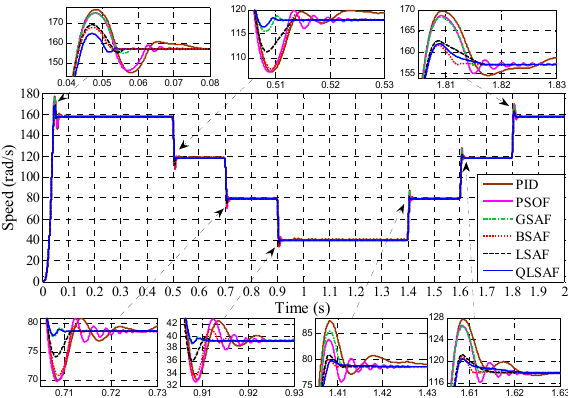
Figure 18. Speed response for constant load with speed variations in steps.